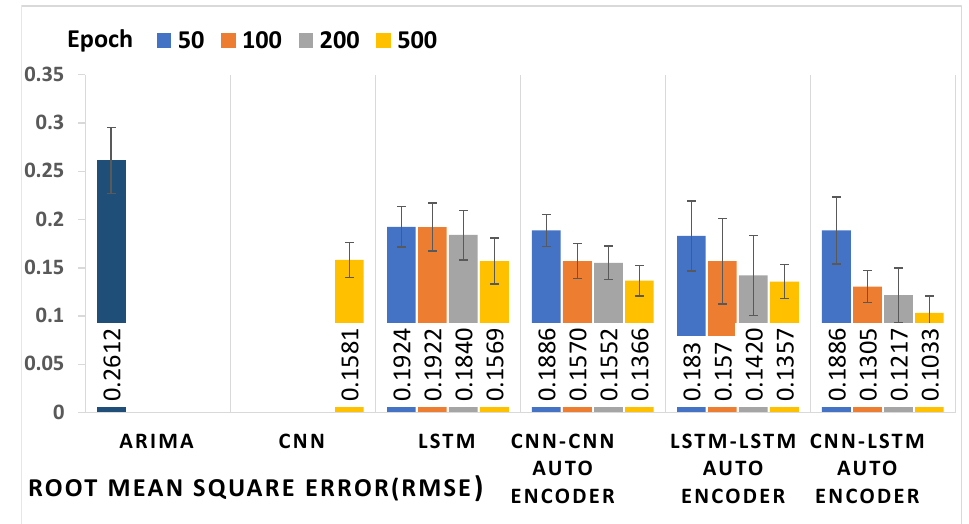
Figure 8. RSME of different forecasting